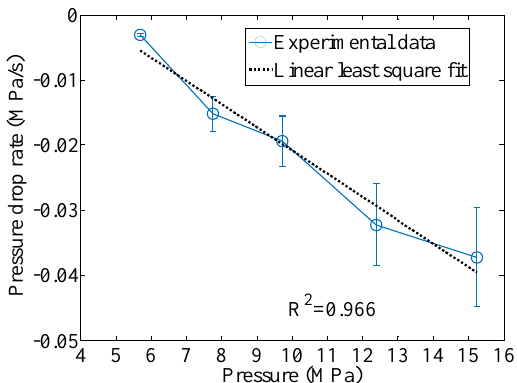
Figure A1. Experimental leakage measurement. Note that the linear least square fit of the experimental data showed the coefficient ( C 1 ) of the pressure drop rate with respect to the accumulator pressure is 0.0036 MPa/s per 1 MPa. Note, the regression performance value, R 2 , is 0.966.